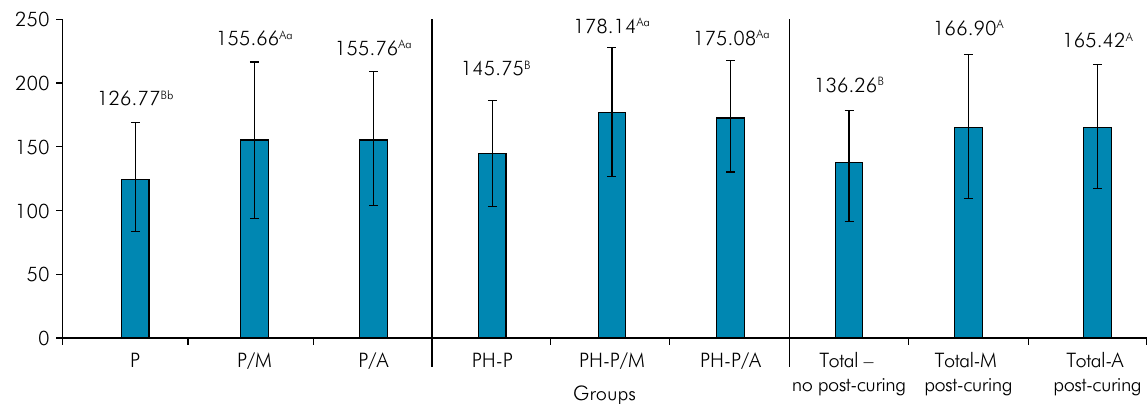
Figure 4. Results of knoop microhardness for